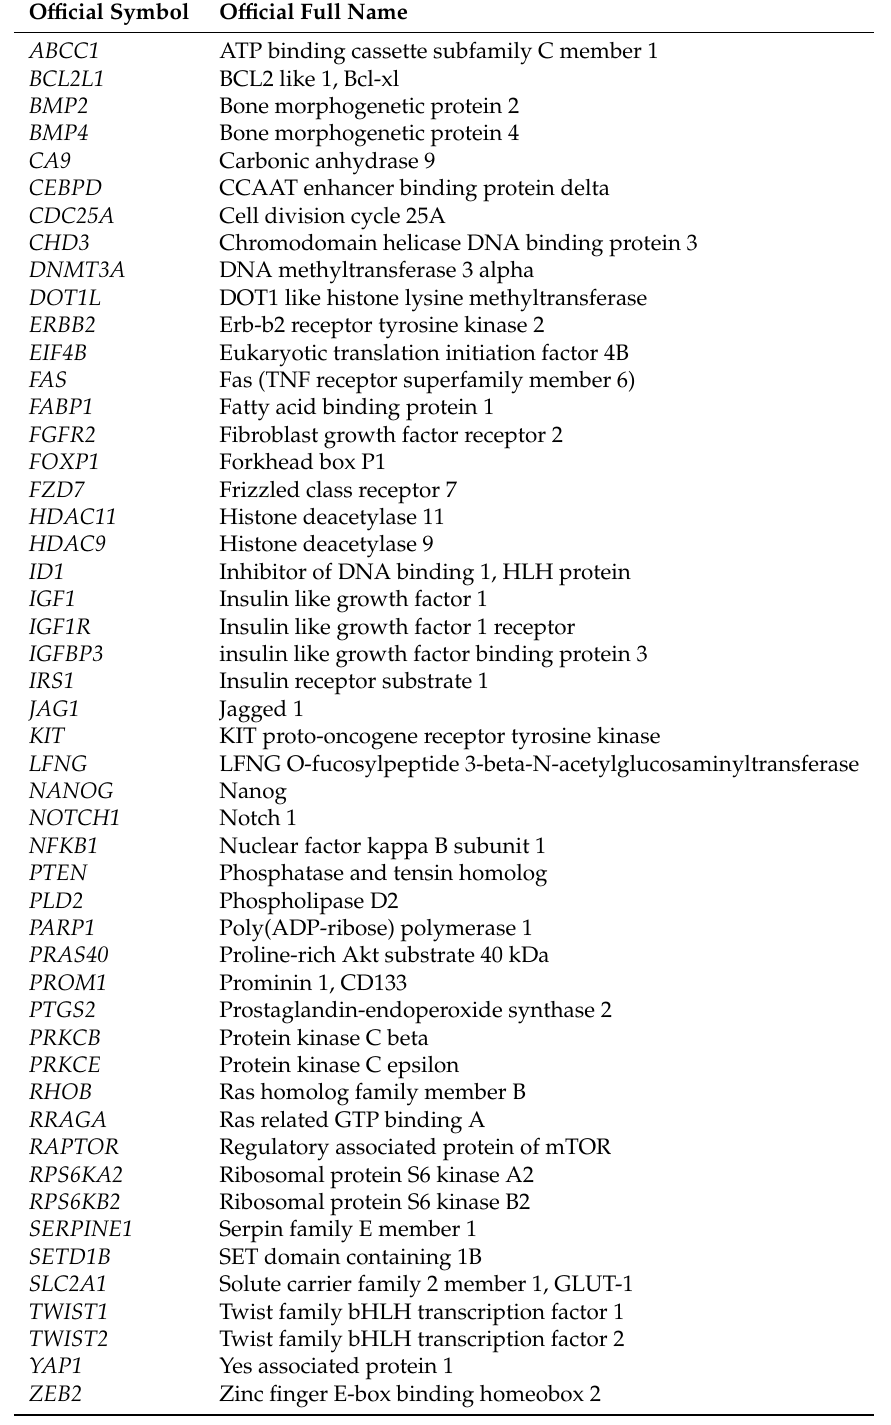
Table 2. O ffi cial full names for genes di ff erentially expressed in